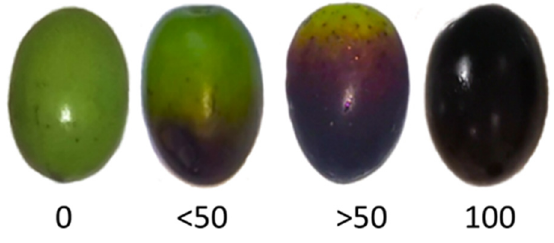
Figure 1. Olives cv. ‘Leccino’ collected at four ripening stages: 0—entirely green or yellow, <50—less than half colored, >50—more than half colored, 100—entirely colored.